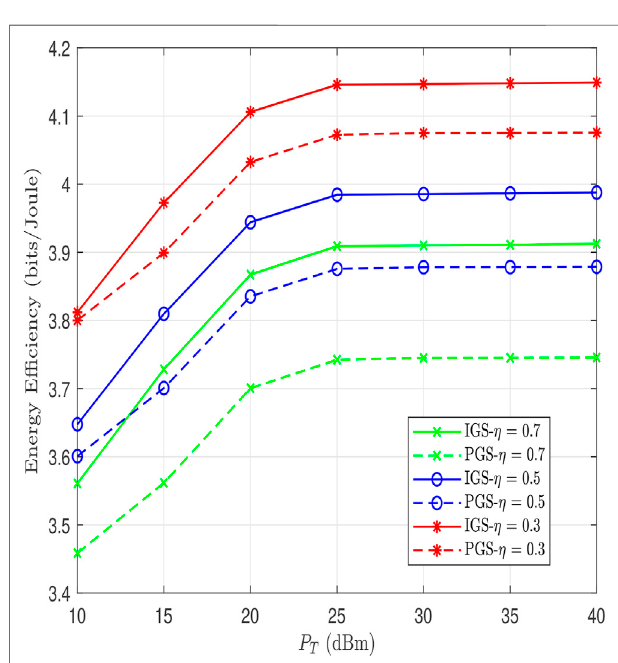
FIGURE 8 | Energy ef fi ciency vs. P (dBm) at different values of η and fi xed P c = 20 dBm.